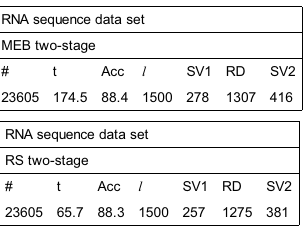
Table 3. Two-stage SVM classification results on RNA sequence data set